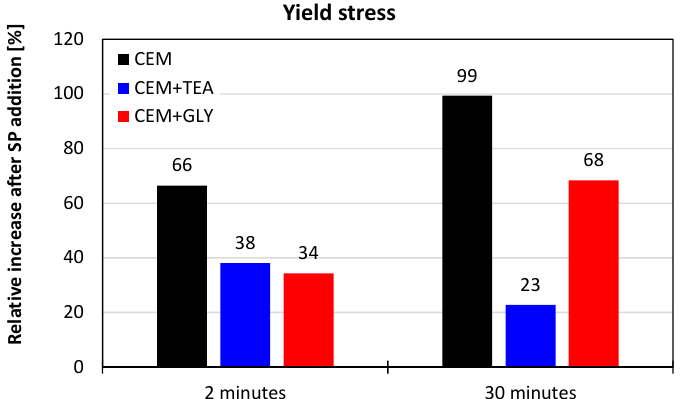
Figure 13. Influence of TEA and GLY on the effectiveness of the superplasticizer—relative increase in the yield stress value after the addition of superplasticizer; data for high shear rates (100–1022 s − 1 ).